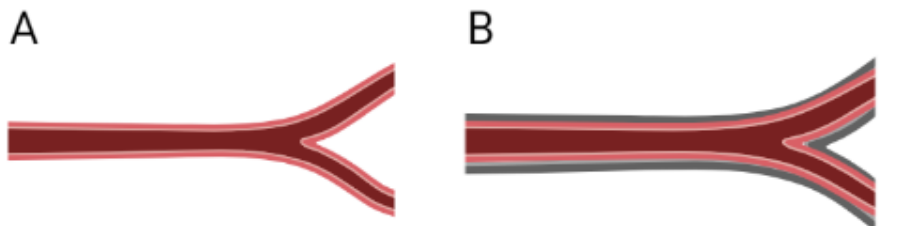
Figure 2. When the remodeling process of the graft induces a fibrotic novo adventitia ( A ) Physiological remodeling of the vascular wall, with thin non-fibrotic novo adventitia ( B ), the outermost external layer of the remodeling vessel is mainly composed of dense fibrotic tissue. This implies that its compliance and therefore capacity to adapt to pressure changes is impaired. Furthermore, the newly formed vessel is surrounded by a thicker, more rigid and denser layer that becomes an obstacle for cell migration from the perivascular tissue to the wall of the graft and limits oxygen and nutrient availability to the cells recently infiltrated in the graft. This not only limits the vascular wall remodeling but also the endothelial lining formation and maturation. (Created with BioRender.com, accessed on 3 February 2022).